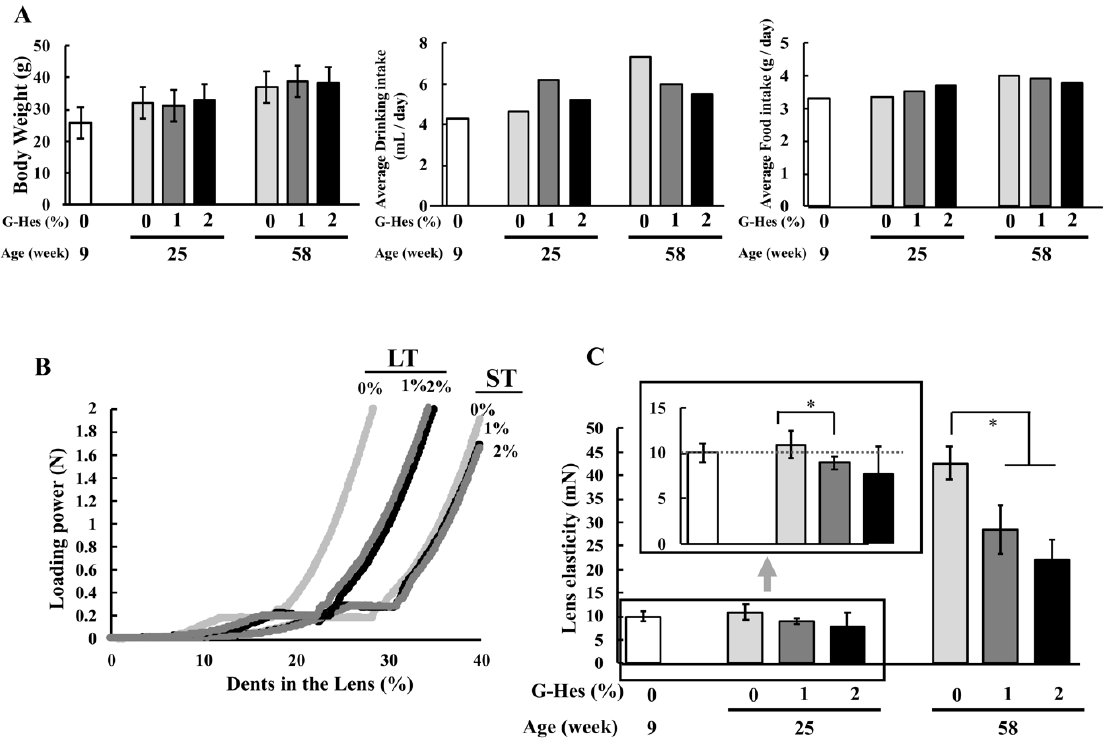
Figure 2. Effect of G-Hsd consumption on lens hardening. Experimental procedure for G-Hsd treatment. C57BL/6 mice were divided into six groups: treated with 0%, 1%, or 2% G-Hsd for 16 weeks (short-term exposure) or 49 weeks (long-term exposure). ( A ) After G-Hsd treatment for 16 or 49 weeks in 9-week old mice, body weight at 25 weeks and 58 weeks of age, water intake and food consumption were measured. ( B ) Young modulus was measured using Softmeasure YAWASA texture. ( C ) Lens elasticity was calculated as the loading power (mN) to achieve 15% dents in the lens. The experiments used three to five independent samples per group. Data are presented as mean ± SEM. * indicates a significant difference versus the control group ( p < 0.05) ( n = 6 to 8